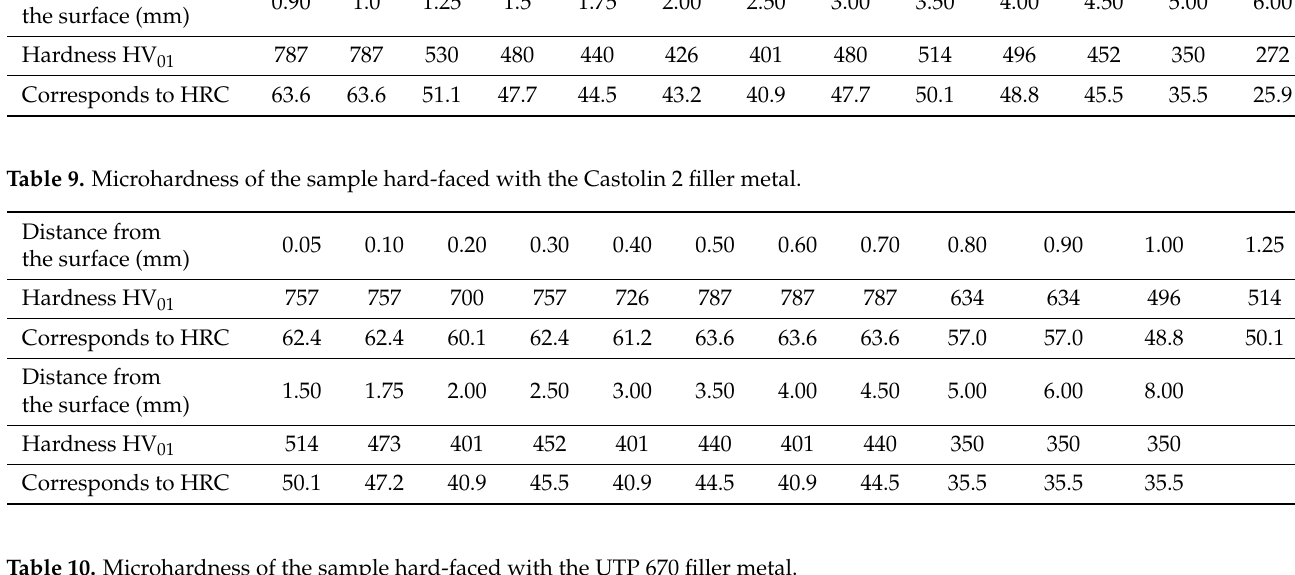
Table 10. Microhardness of the sample hard-faced with the UTP 670 filler metal. Distance from the surface